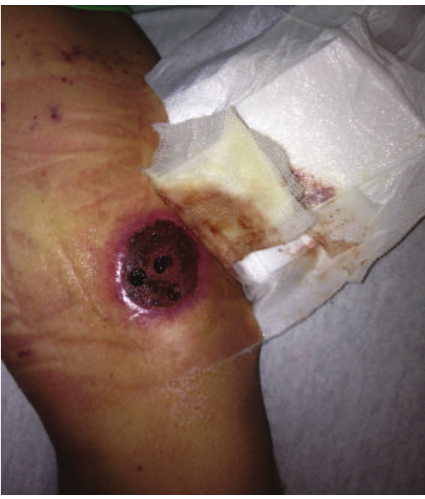
Figure 1: Cutaneous aspergillosis.